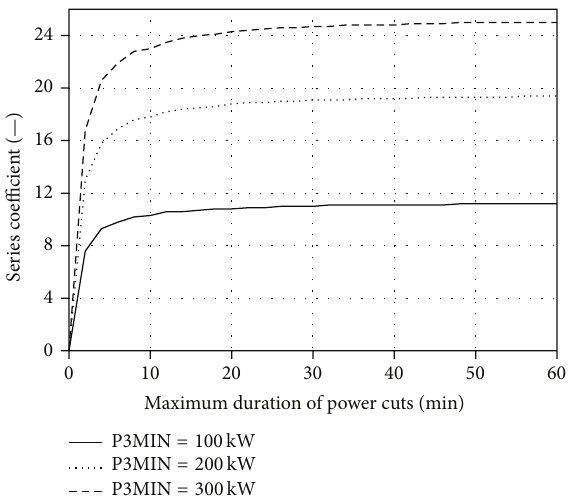
Figure 8: Family of characteristics 𝑘 1 = 𝑓(𝑇 turbine, height: ℎ 𝑤 = 60 m for the period between 1 Jan. 2010 and 31 Mar. 2010.